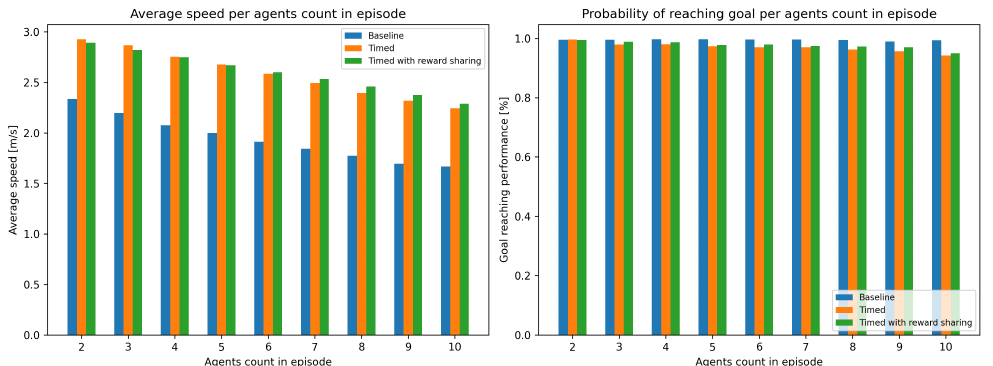
Figure 11. The average speed of the agents ( left ) and the goal reaching performance ( right ) as a function of the number of agents simulated in a given scenario. The obvious conclusion is that the average velocity drops as more cars are present in the scenario. Interestingly, the reward-sharing mechanism (green plot) improves the average velocities in dense scenarios (agent count in the scenario above 5) and slightly reduces it in cases where the number of agents is smaller (with respect to the reward mechanism being turned off). Goal reaching is improved by reward sharing independent of the number of agents; however, the baseline policy (blue) was superior in all cases. Those results suggest that reward sharing plays an important role in environments with denser